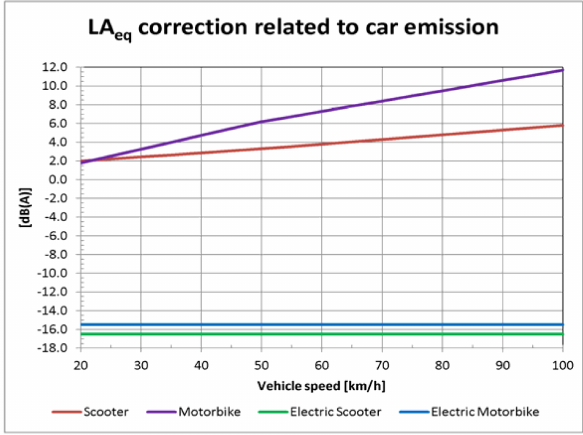
Figure 6: L Aeq correction for PTWs as a function of speed. ensuring the accuracy of the acoustic model of the test site (see relevant diagrams in Figures 3, 4,